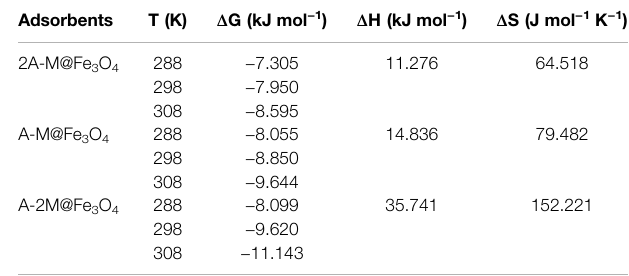
TABLE 3 | The adsorption thermodynamic parameters of bifunctional PSQ/CNTs magnetic composites for Hg(II) at different temperatures. Adsorbents